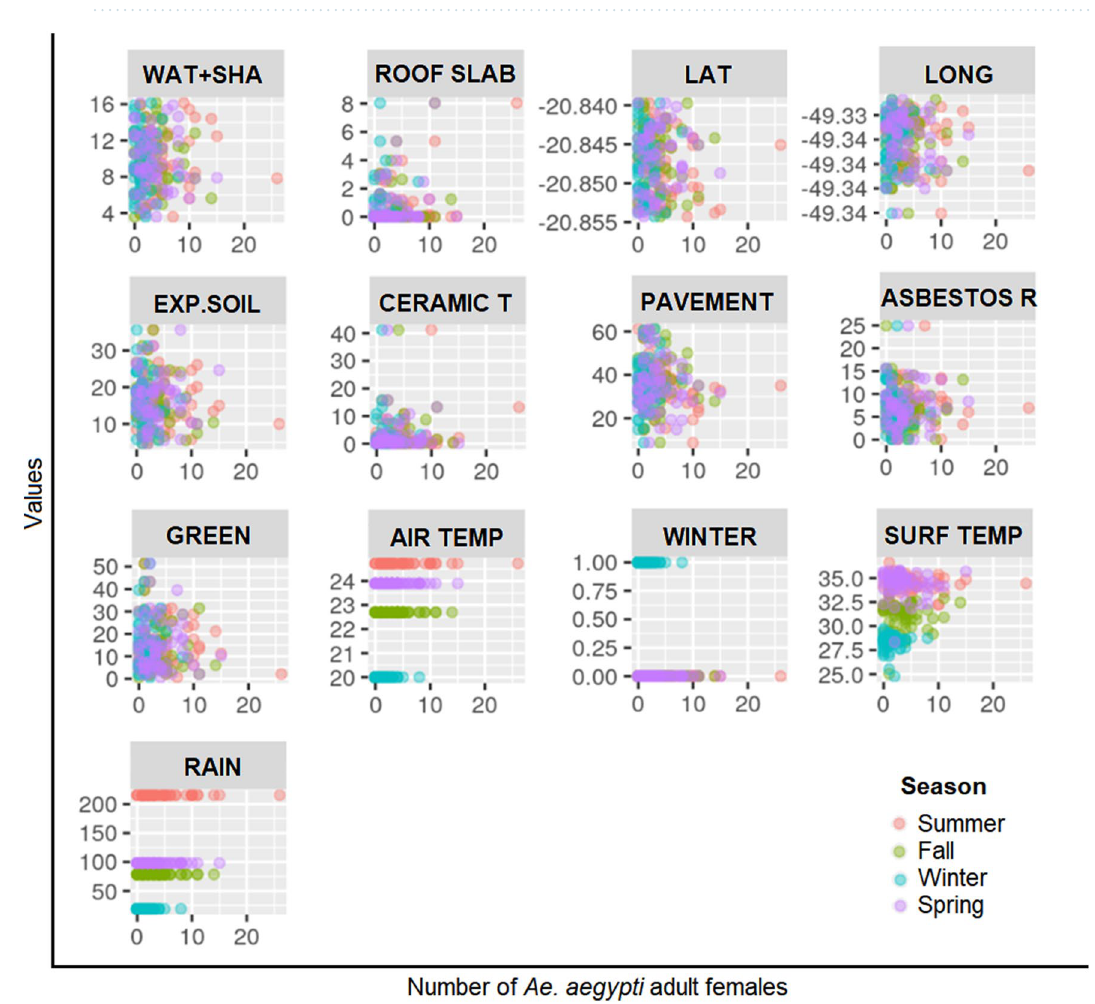
Figure 4. Scatterplots of each independent variable tested with the number of mosquitoes considering each season. Landcover categories (in %): WAT + SHA water and shadow, EXP.SOIL exposed soil, CERAMIC T ceramic tile, ASBESTOS R asbestos roof, GREEN green areas (trees and grass), AIR TEMP average season temperature (ºC), WINTER binary variable indicating if is winter season or not, SURF TEMP surface temperature (TIRS Landsat 8, ºC), RAIN average season rainfall